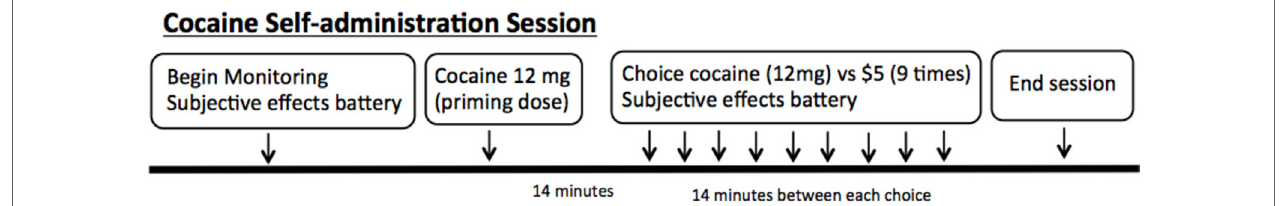
FigUre 1 | Schematic of the cocaine self-administration sessions in the laboratory. Each session begins with monitoring and subjective effects battery. A “priming dose” of cocaine is delivered, followed by nine options for the subjects to choose between 12 mg smoked cocaine or $5.